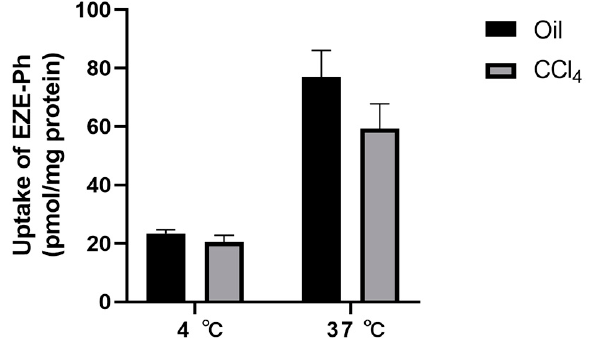
Figure 8. Uptake of EZE-Ph in liver slices of control and CCl 4 -induced rats. Data are expressed as mean ± S.D. ( n = 3).